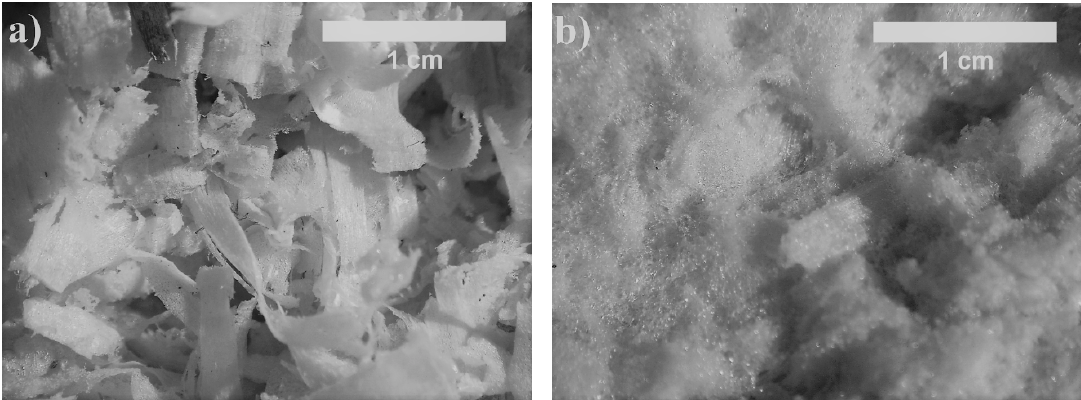
Figure9. SurfacesofPURbiocompositefoamsaftertensiletest: ( a )0.40PURb / WSand( b )0.70PURb / Figure 9. Surfaces of PUR biocomposite foams after tensile test: ( a ) 0.40 PURb/WS and ( b ) 0.70 PURb/WS.